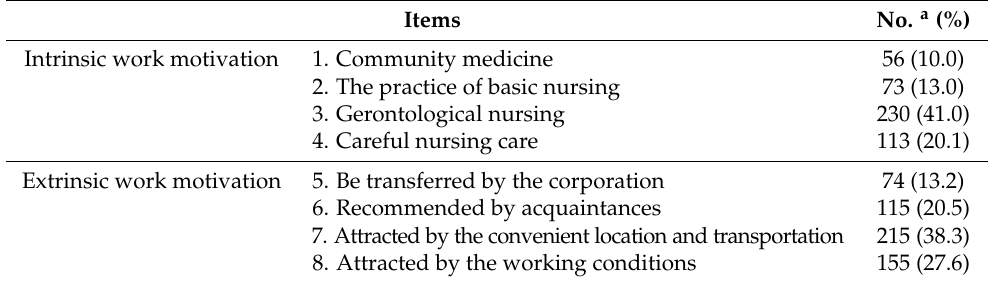
Table 2. Selection of each work motivation item: Frequency and proportion of participants (N = 561).